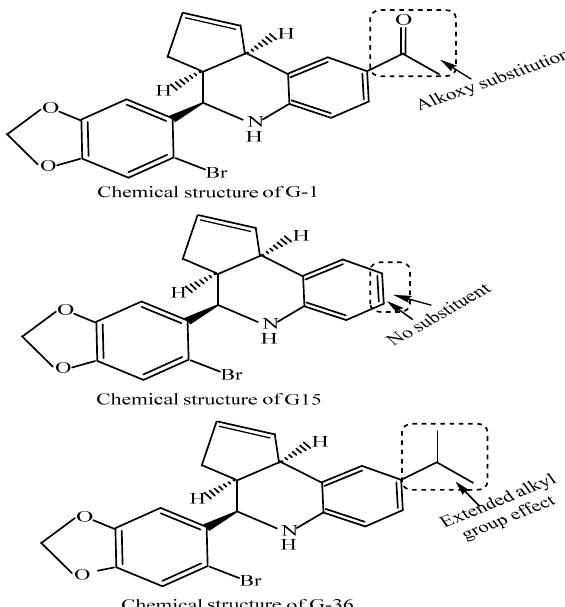
Figure 5. Chemical structures of the GPER antagonists, G-1, G-15 and G-36. The structures of these compounds distinguish an influence of extended alkyl, alkoxy and null substitution in the terminal rings. Though G-36 has been reported only recently for its reduced non-specific response, the G-15 has been listed in 2019 only for its anti-estrogen-mediated control of NSCLC growth.